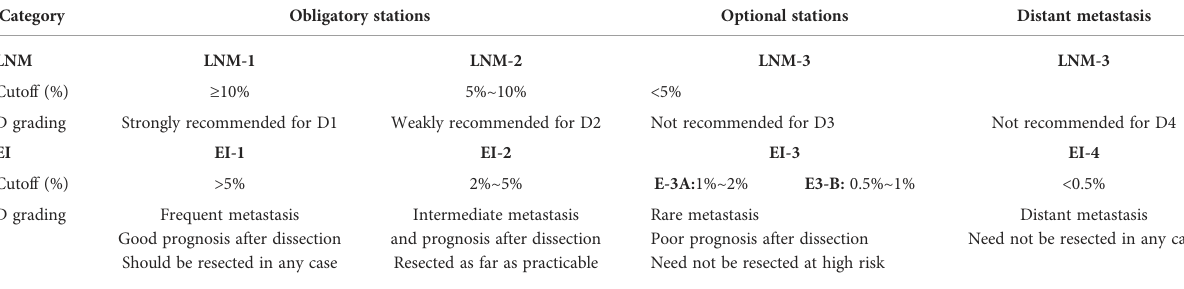
TABLE 2 The grading of lymph node dissection according to metastatic rate and ef fi ciency